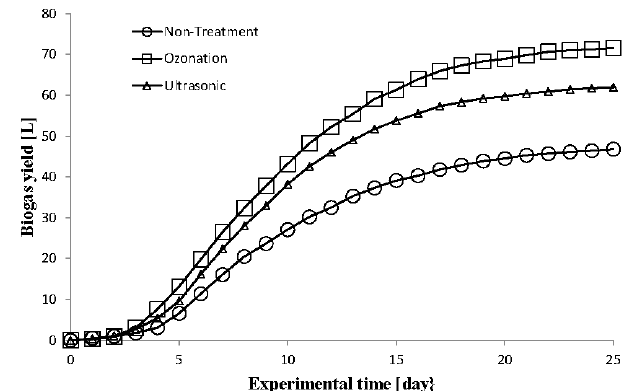
Figure 5. The cumulative biogas productions from anaerobic digestion of digested sludges pretreated by ultrasound and